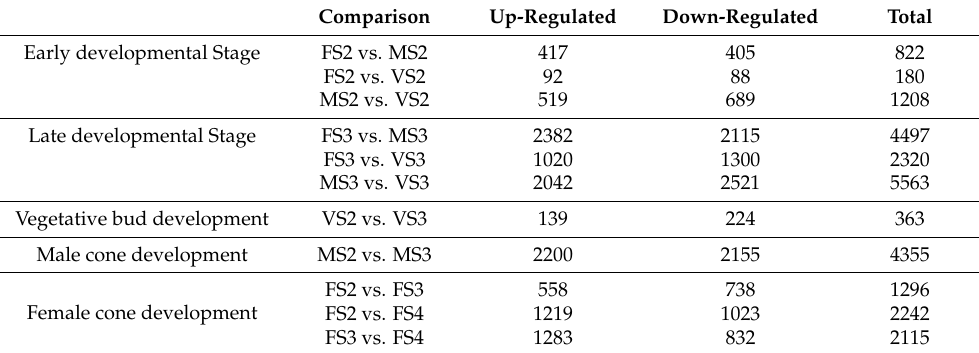
Table 2. Number of differentially expressed genes between the different bud types, and between the developmental stages in each bud type.